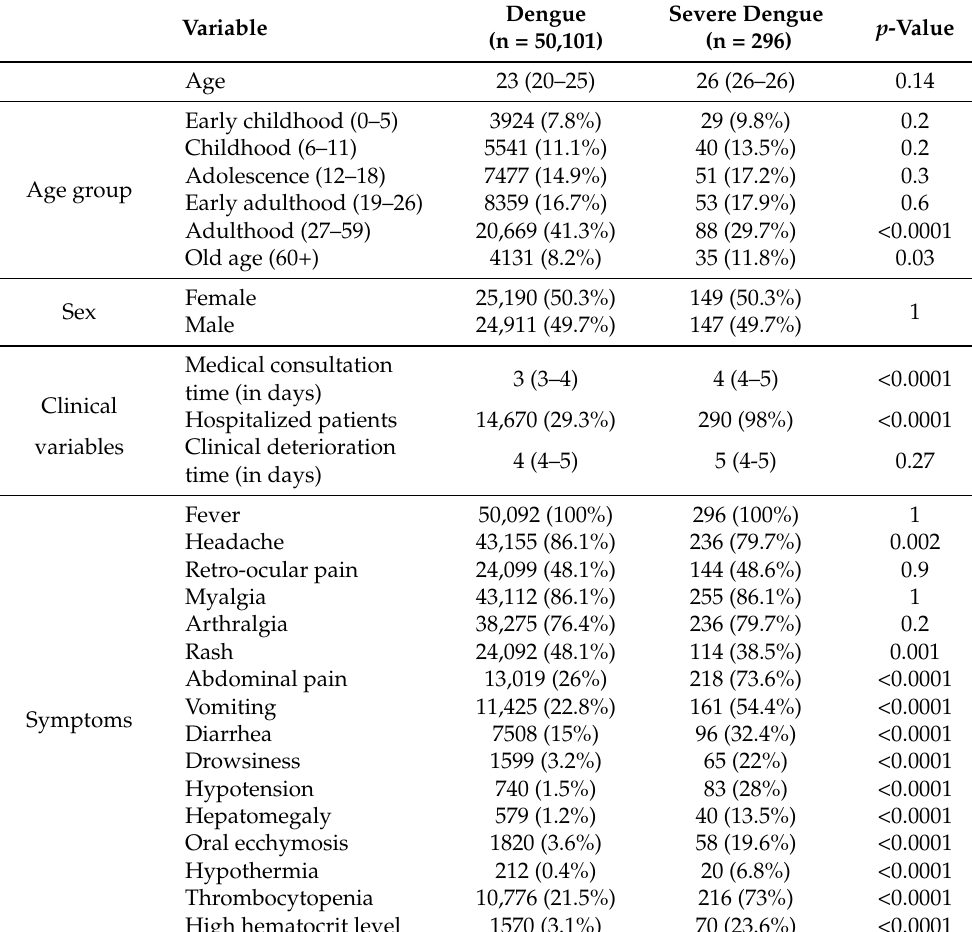
Table 8. Social, medical, and symptomatological characteristics among patients according to dengue